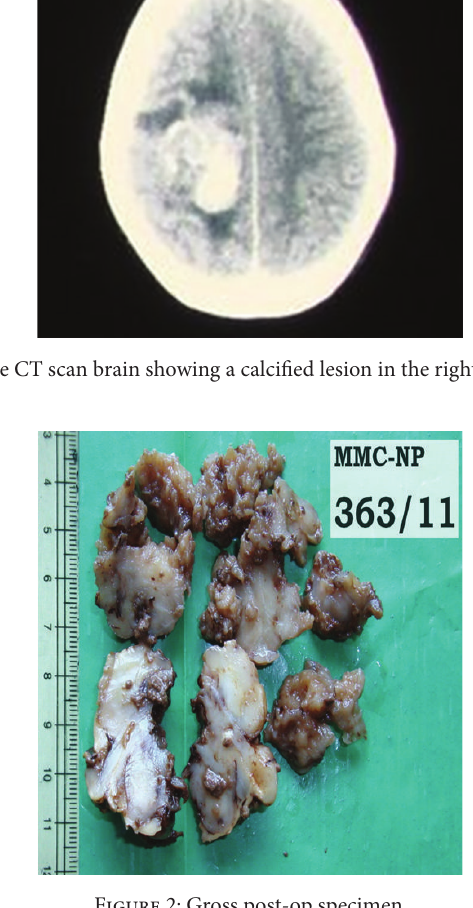
Figure 2: Gross post-op specimen.